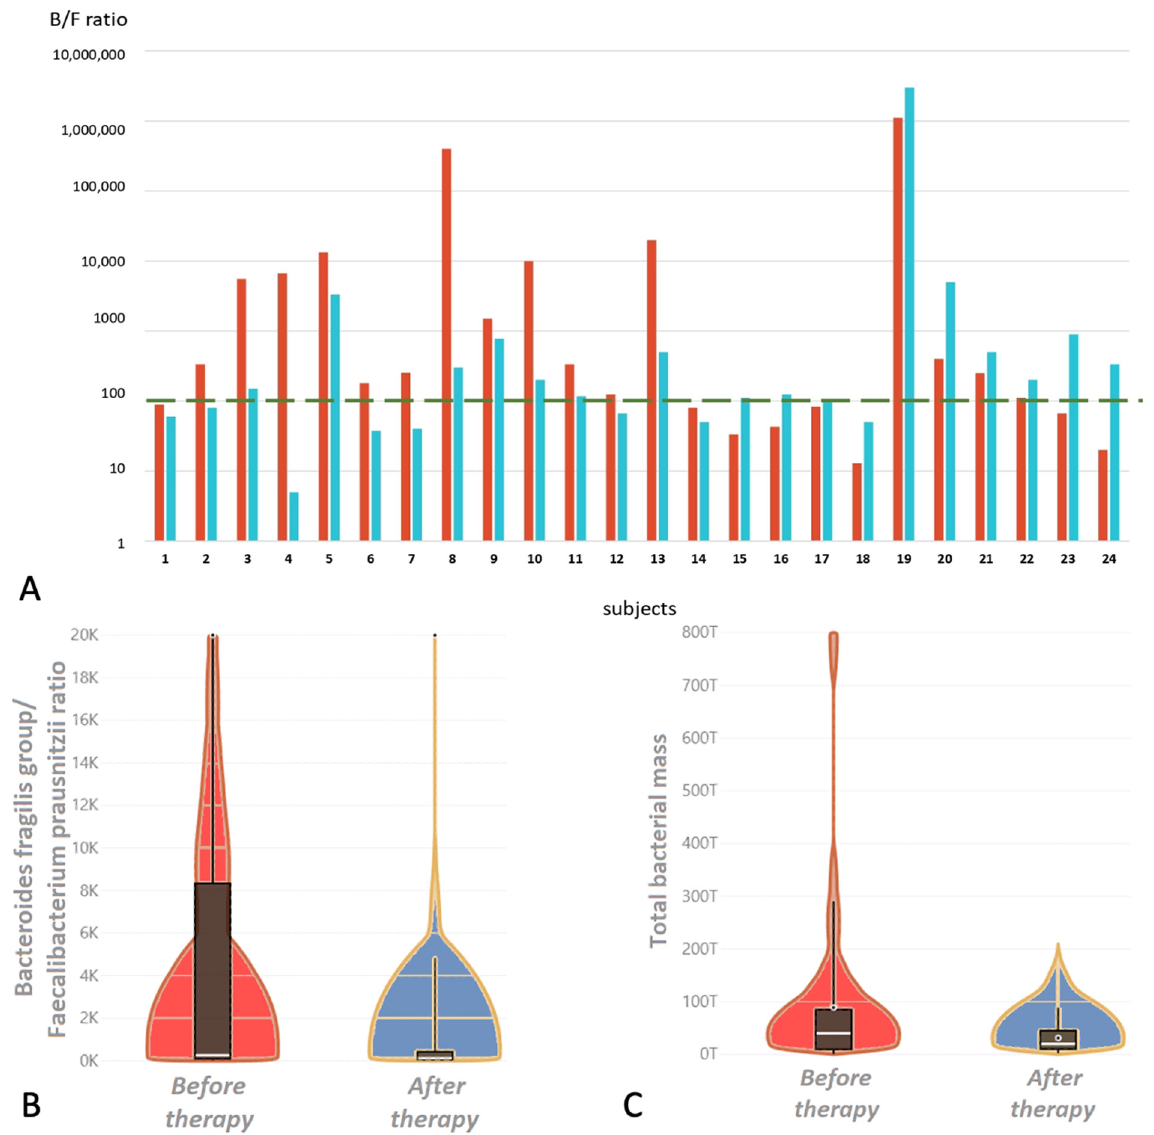
Figure 4. ( A ). Bacteroides fragilis group/Faecalibacterium prausnitzii ratio in subjects during therapy with bacteriophage cocktail; red bars before therapy, blue bars after. The green dotted line is the boundary of the reference value. Only 25% of the subjects had an increase in this indicator compared with the baseline. ( B ). Violin plot distribution of the Bacteroides fragilis group/Faecalibacterium prausnitzii ratio during therapy with bacteriophage cocktail; the red bar before therapy, the blue bar after. ( C ). Violin plot distribution of the total bacterial mass during therapy with bacteriophage cocktail; the red bar before therapy, the blue bar after.